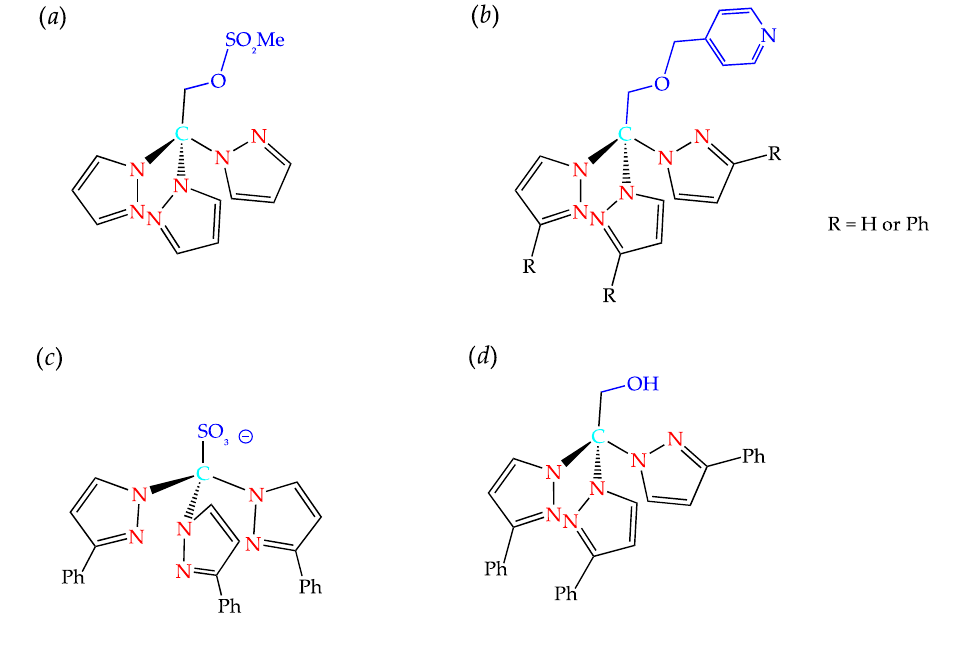
Figure 3. Structures of functionalized tris(pyrazol-1-yl)methanes: ( a ) CH 3 SO 3 CH 2 C(pz) 3 ; ( b )